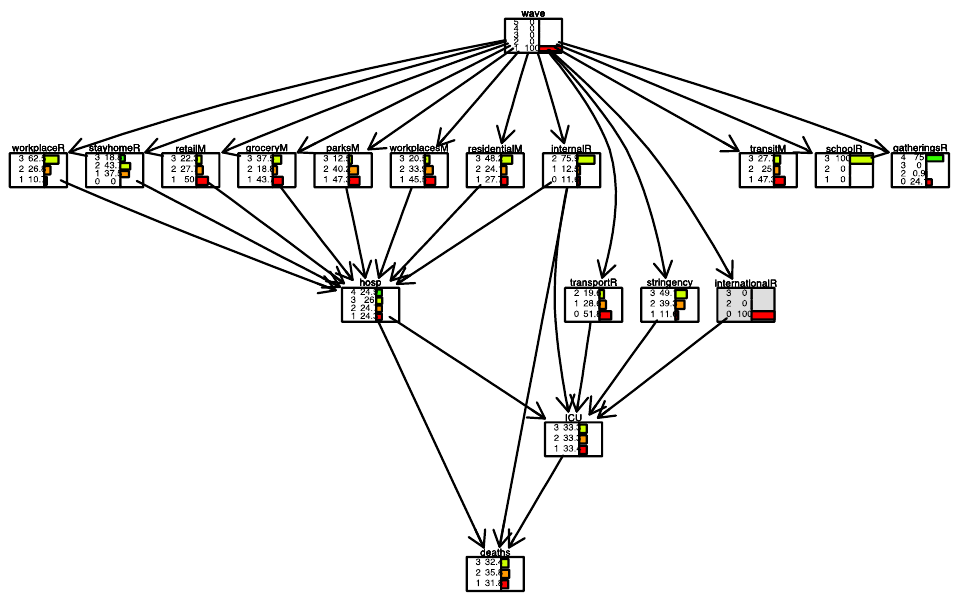
Figure 8. Scenario for Italy when international movements restriction is set to 0. International movement restriction node is highlighted in